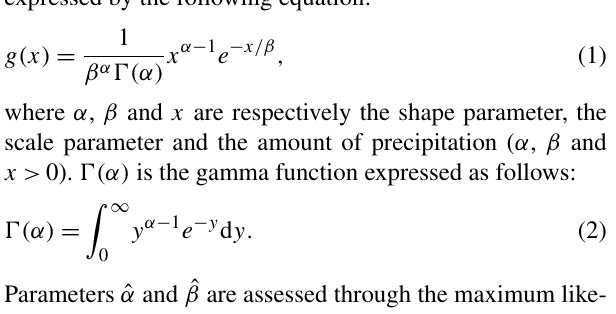
Table 1. Classification of wet and dry conditions according to SPI values (McKee et al.,